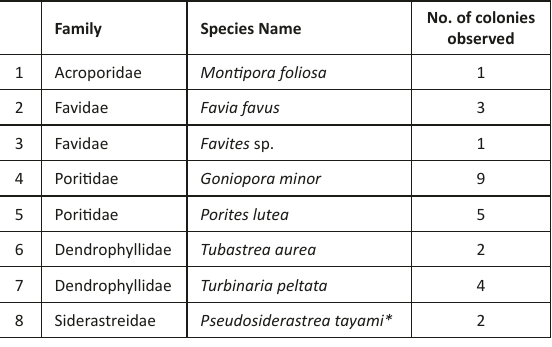
* Did not occur in Transects